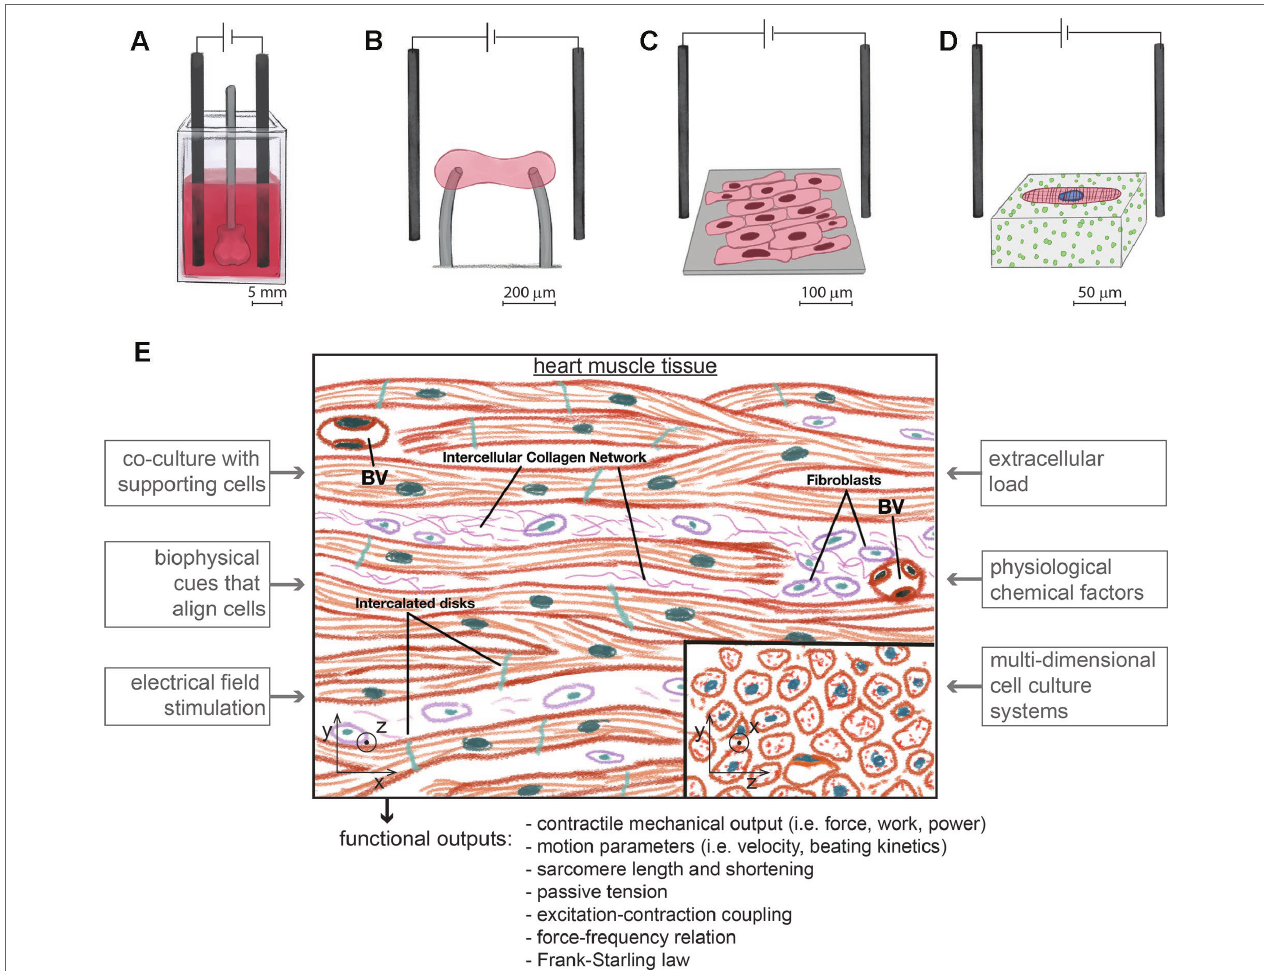
FIGURE 1 | Different types of experimental platforms to assay the contractility of hiPSC-cardiomyocytes with physiological relevance, at different length scales and under electrical pacing. (A) . Engineered human ventricular cardiac organoid chambers contain co-cultures of hiPSC-cardiomyocytes with dermal fibroblasts organized in 3D, have the ability to be electrically paced, and produce a cardiac mechanical output, while being exposed to different levels of pressure (Li et al., 2018) (B) . Engineered heart tissues are organized in 3D with aligned morphologies immobilized between force sensors and also contain co-cultures of hiPSC- cardiomyocytes with fibroblasts (Hinson et al., 2015 ;Ronaldson-Bouchard et al., 2018). (C) . Monolayers of cells with an aligned rectangular morphology collectively beat and contract along the direction of alignment (Carson et al., 2016). (D) . Single hiPSC-cardiomyocytes are micropatterned on gels to assume a rectangular physiological shape and aligned sarcomeres. Cell contractility is measured with traction force microscopy (Ribeiro et al., 2017). (E) . Experimental approaches to develop platforms with hiPSC-cardiomyocytes to model cardiac contractility. The microenvironment of heart tissue is multicellular and aligned in 3D. Fibroblasts coexist with interconnected cardiomyocytes. Blood vessels (BV) are densely distributed. Inspired in the biological properties of heart tissue, different factors of an in vitro microenvironment enhance the maturity of hiPSC-cardiomyocytes in platforms for assaying cardiac contractility. These platforms should measure different types of contractile functional outputs. Image based on (Shepherd and Vanhoutte,